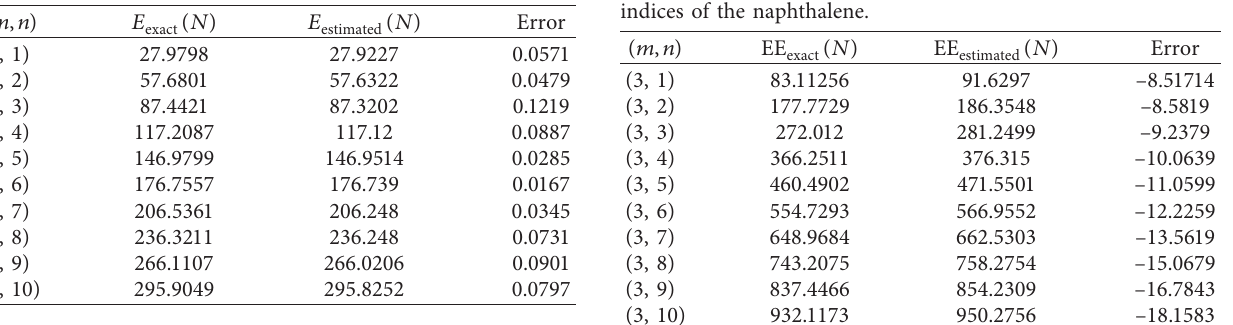
( N ) and EE ( N ) values of the Estrada exact estimated